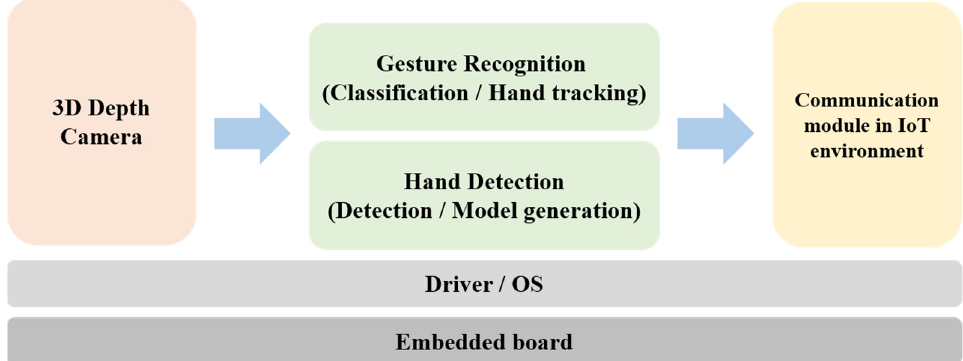
Figure 5. Configuration diagram of the proposed gesture recognition system.